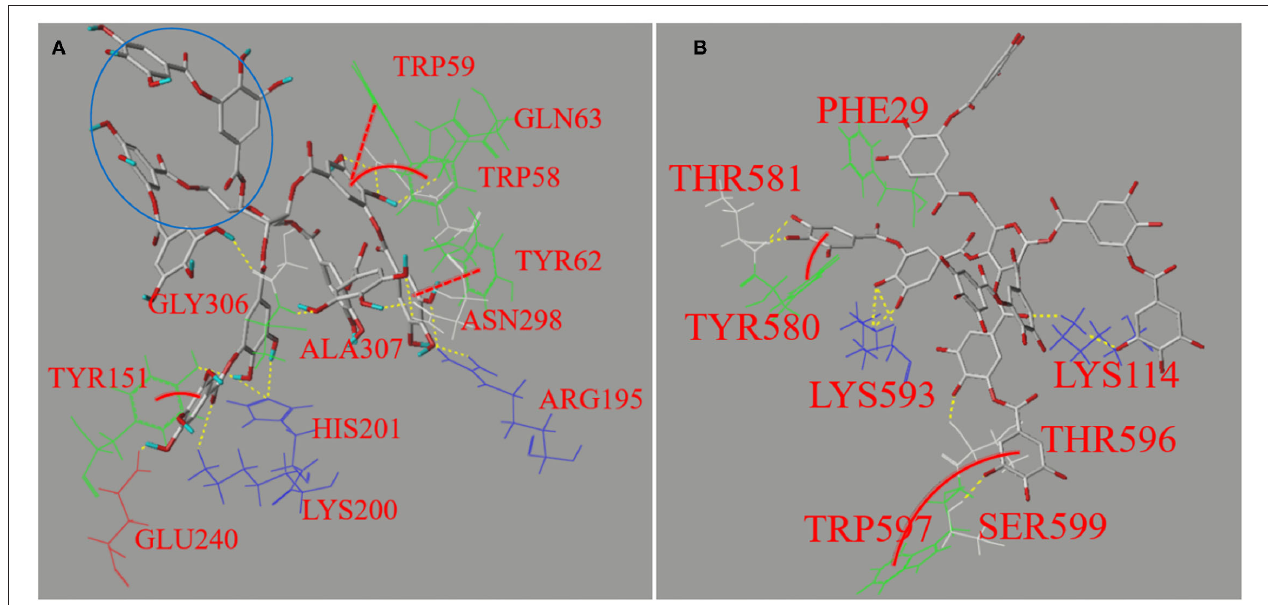
FIGURE 6 | The molecular docking profiles for non-covalent binding interactions of TA with AA (A) and AMG (B) , respectively. The interaction forces between the polyphenol moieties and the amino acid residues involved hydrogen bondings (yellow dashed lines) and π - π hydrophobic forces, such as parallel conjugations (red full lines) and vertical ones (red dashed curves). Besides, the area in blue circle indicates the phenolic moieties that may not enter the active site of AA according to the applied docking